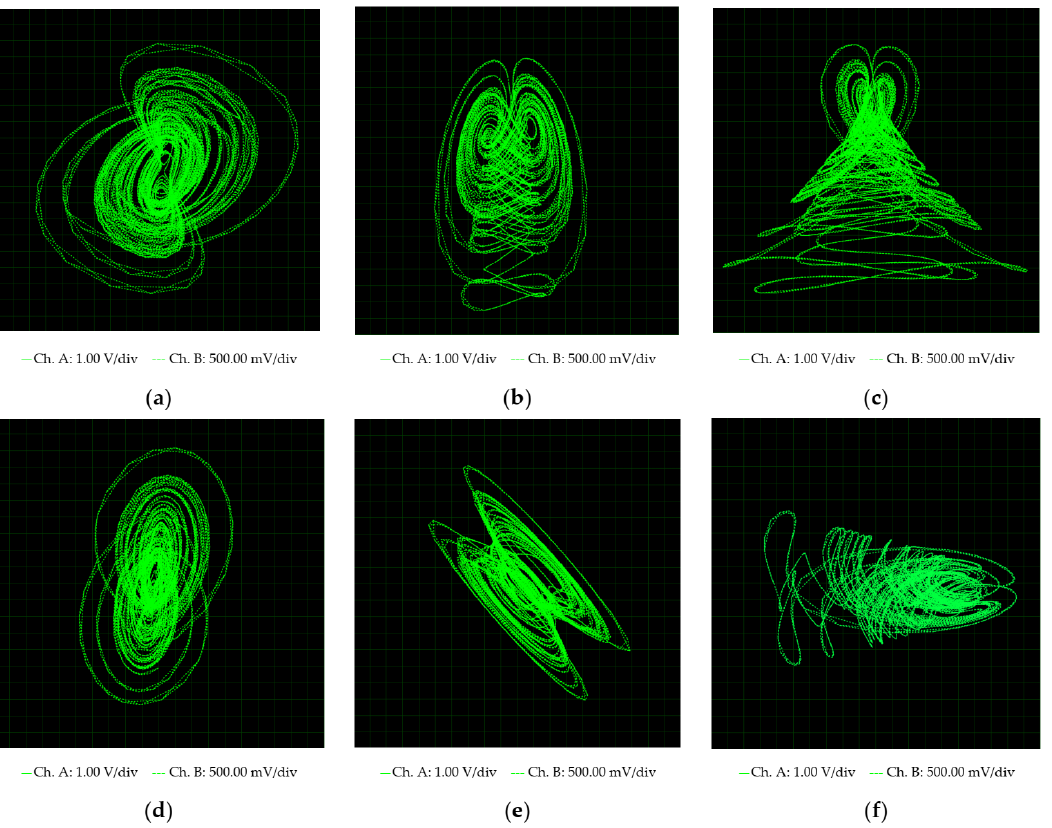
Figure 5. Electronic simulation of system (11) using Proteus VSM: ( a ) phase plane x versus y ; ( b ) phase plane x versus z ;